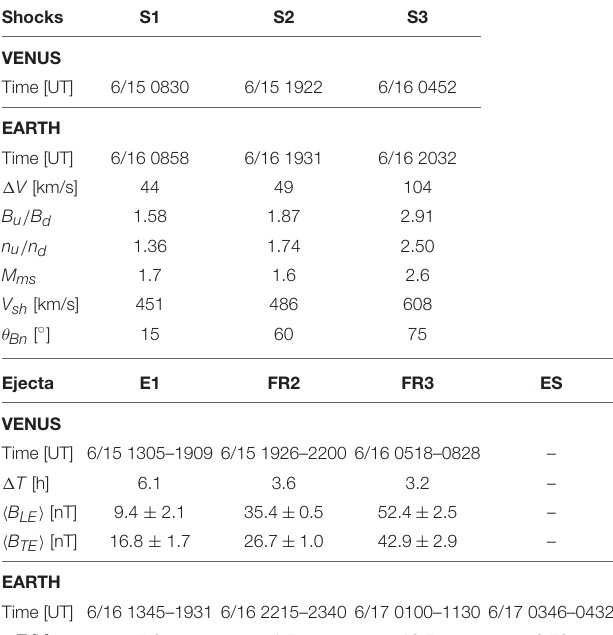
TABLE 3 | Observation times of interplanetary shocks (S), ejecta (E) and flux ropes (FR) around Venus (in VEX data) and Earth (in Wind